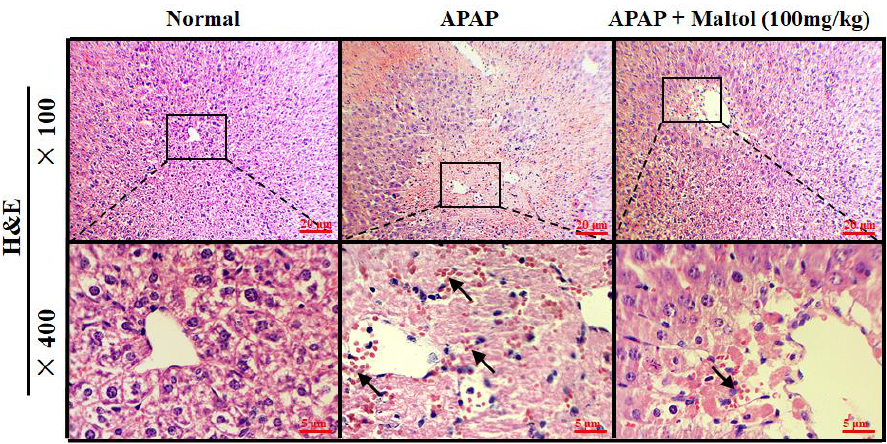
Figure 3. Liver tissue sections were stained with haematoxylin and eosin (H&E) for evaluation of pathological